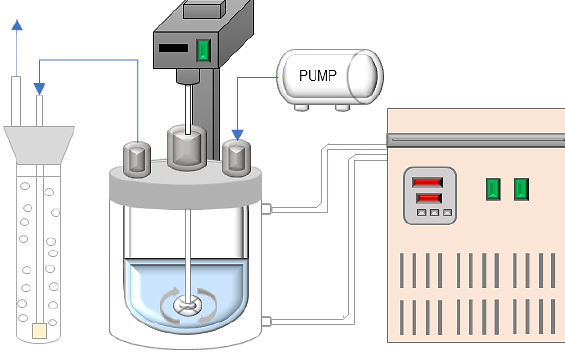
Figure 1. Schematic diagram of leaching-scrubbing system.